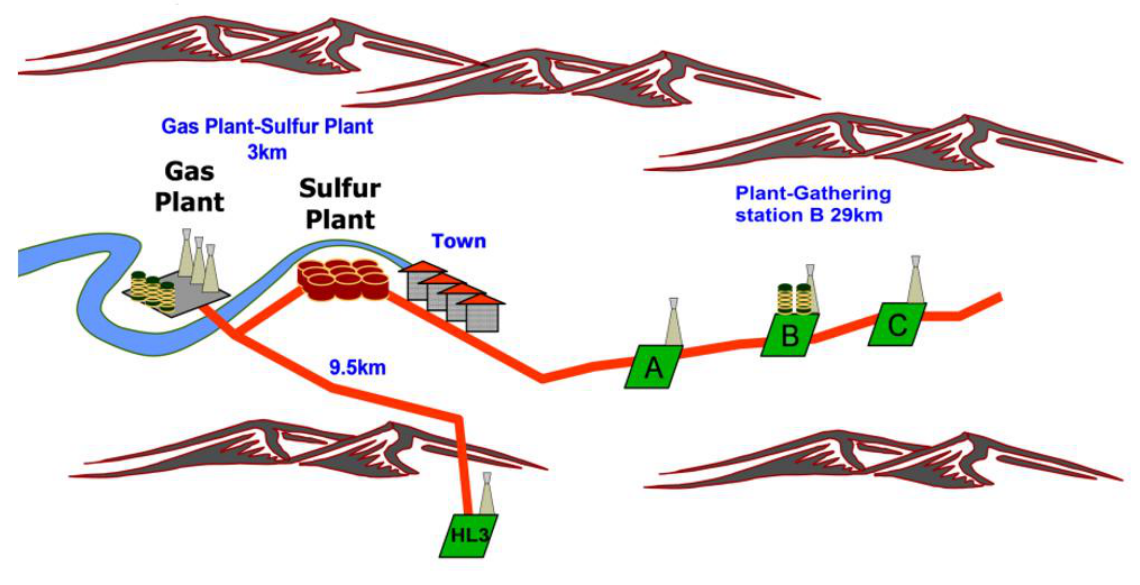
Figure 1—Sour gas development project.